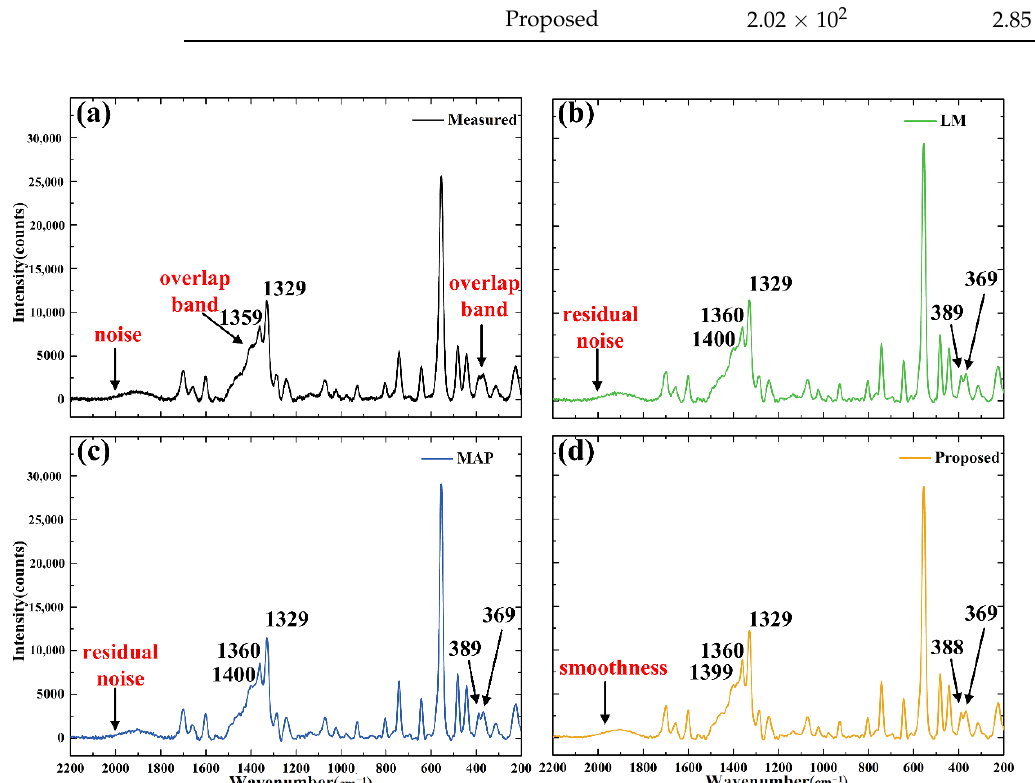
Figure 8. ( a ) Caffeine (C 8 H 10 N 4 O 2 ) measured spectrum and reconstructed spectra with spectral range from 2200 to 200 cm −1 by ( b ) the LM method; ( c ) the MAP method; ( d ) the proposed method.